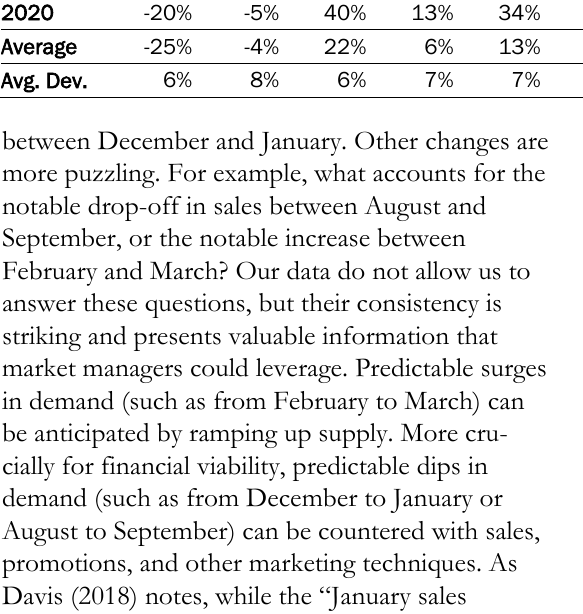
Figure 2. Average Change in Food Sales from Previous